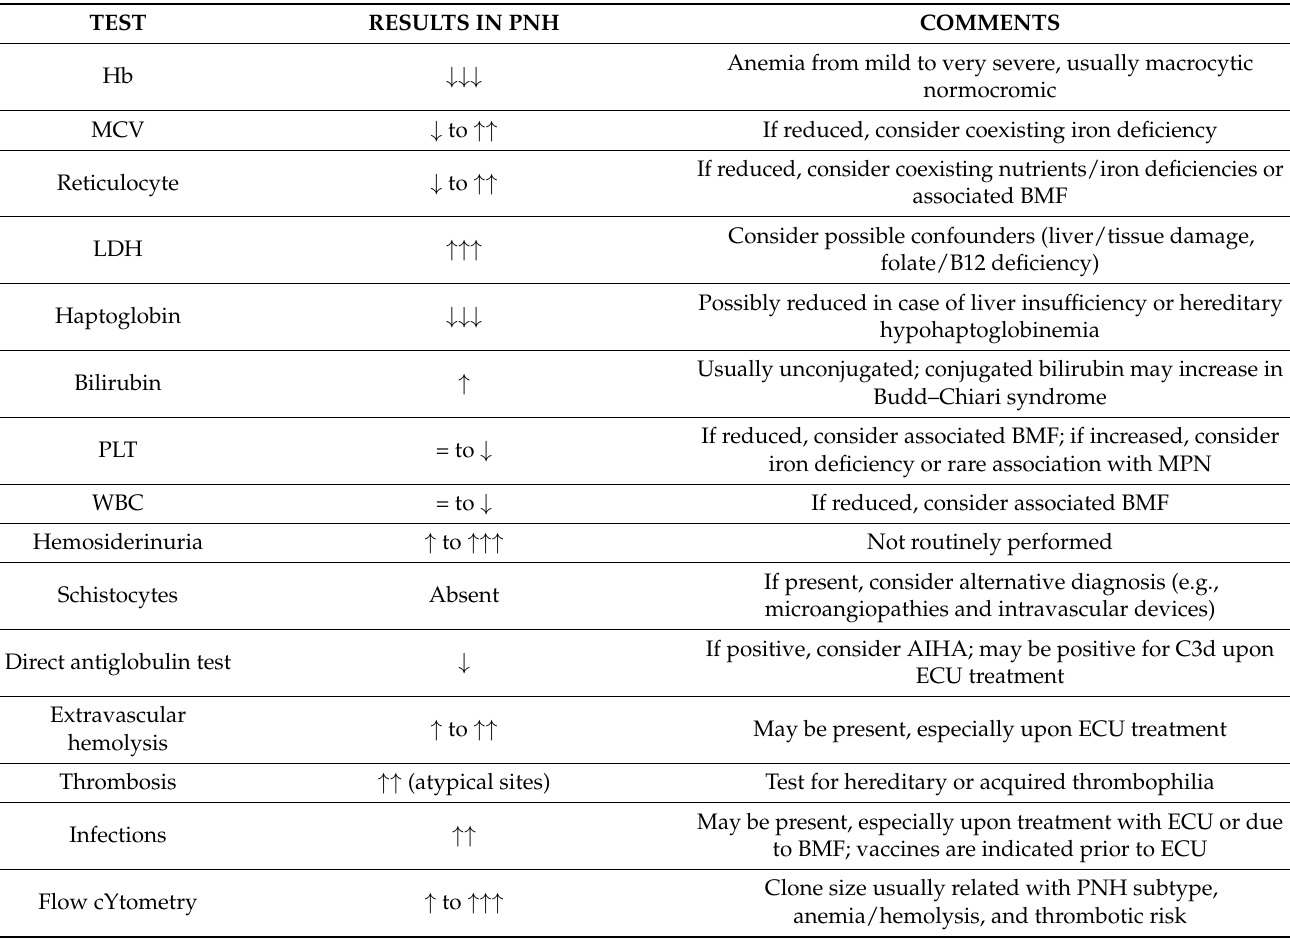
Table 1. Clinical and laboratory characteristics of